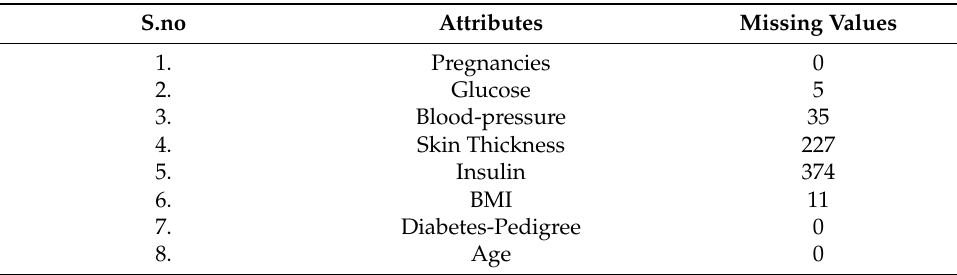
Figure 2. Box plot representation of data along with outliers. Table 2. Missing values in PIMA dataset.